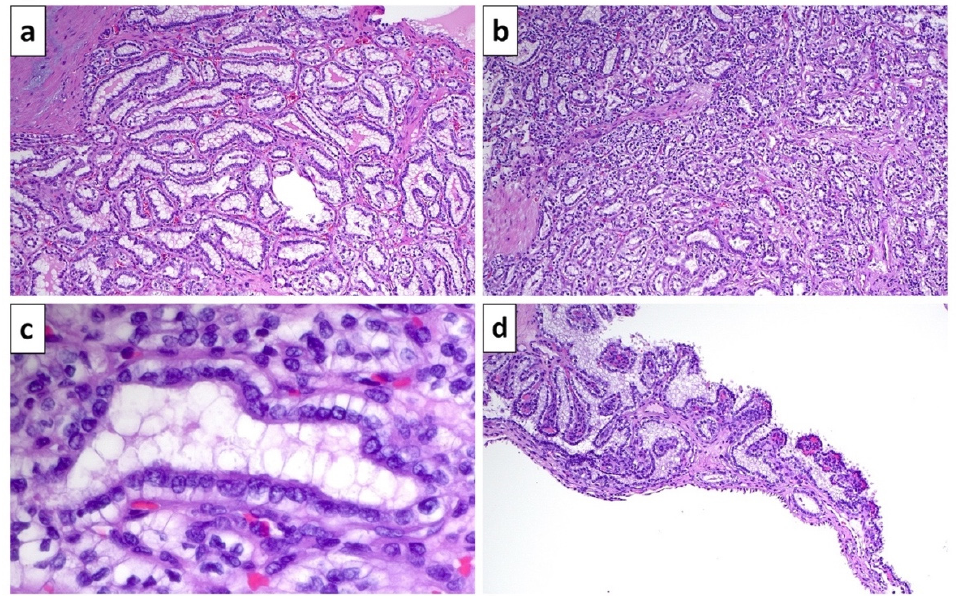
Figure 4. Histological features of ccpRCC. ( a ) Tubular architecture in ccpRCC. ( b ) Areas with tubular and solid or nested architecture of clear cells. ( c ) Clear cells with linear arrangement of nuclei and inverse polarization, which have been described as resembling secretory endometrial glands. ( d ) Cystic septum in ccpRCC with short papillary projections. (Note: Hematoxylin and eosin stained sections, ( a , b , d ) 100× magnification, ( c ) 600× magnification).